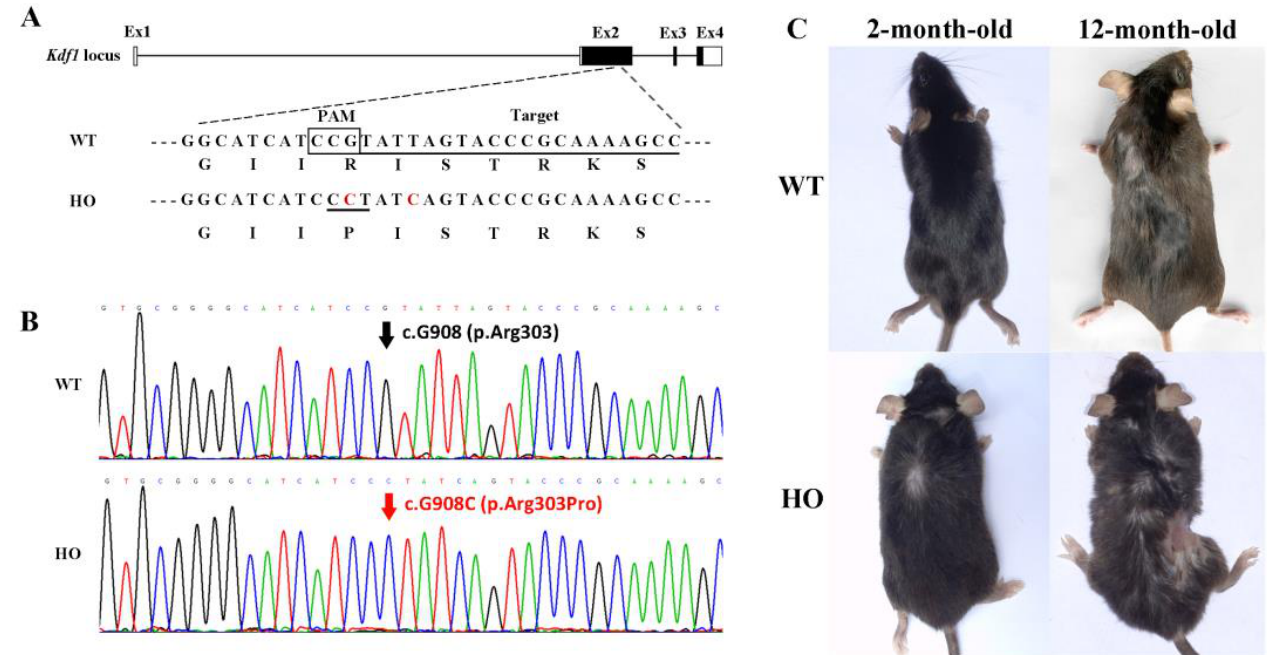
Figure 2. Generation of Kdf1 R303P knock-in mice using CRISPR/Cas9: ( A ) The original sequence in the Kdf1 locus was changed into a knock-in allele c. 908G>C, leading to a pathogenic missense mu- tation. Four exons (Ex1 – 4) were shown in boxes. The sgRNA target sequence and PAM sequence were marked with an underline and a square, respectively. In the knock-in allele, the mutated nu- cleotide is highlighted in red. The base sequences of the wild-type allele and the knock-in allele, respectively, are compared to the amino acid sequences of the original KDF1 protein and the altered protein. ( B ) Sequencing results showed that F2 homozygous mice with c. 908G>C were successfully generated. ( C ) Pictures of 2-month-old and 12-month-old WT and HO mice were shown. The 12- month-old HO mouse showed severe skin damage.